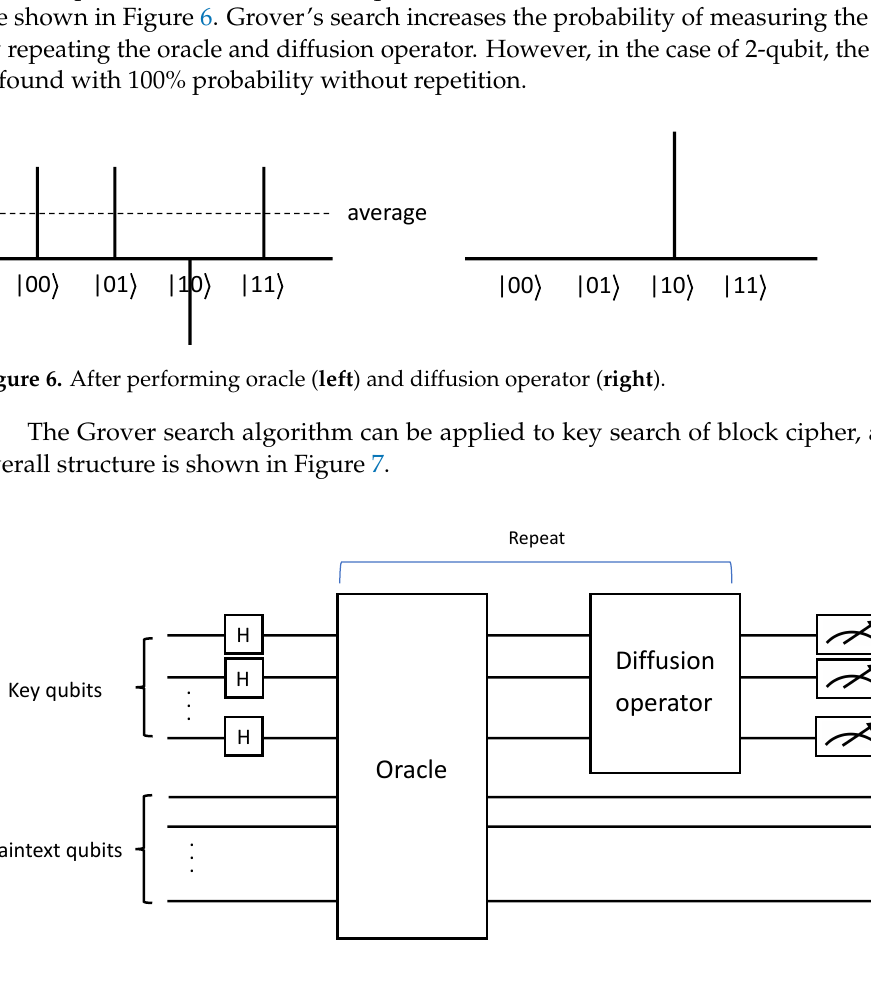
Figure 7. Grover search algorithm for block cipher key